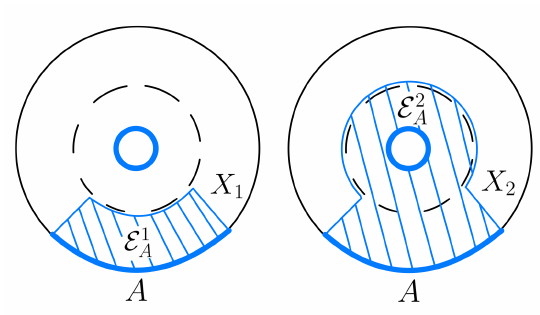
Figure 5 . Here the inner circle (thick blue) τ = ± β is identified between all the replicas. On left 2 the same bulk replicated surface E 1 found for the thermal case figure 2. On the right a second A replicated surface E 2 of a different topology. This solution is allowed only due to the inner circle A